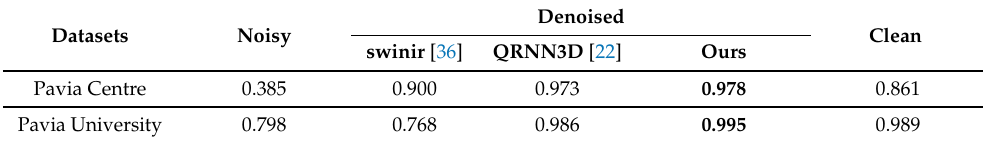
Table 10. Classification results on Pavia University and Indian Pines with different noise